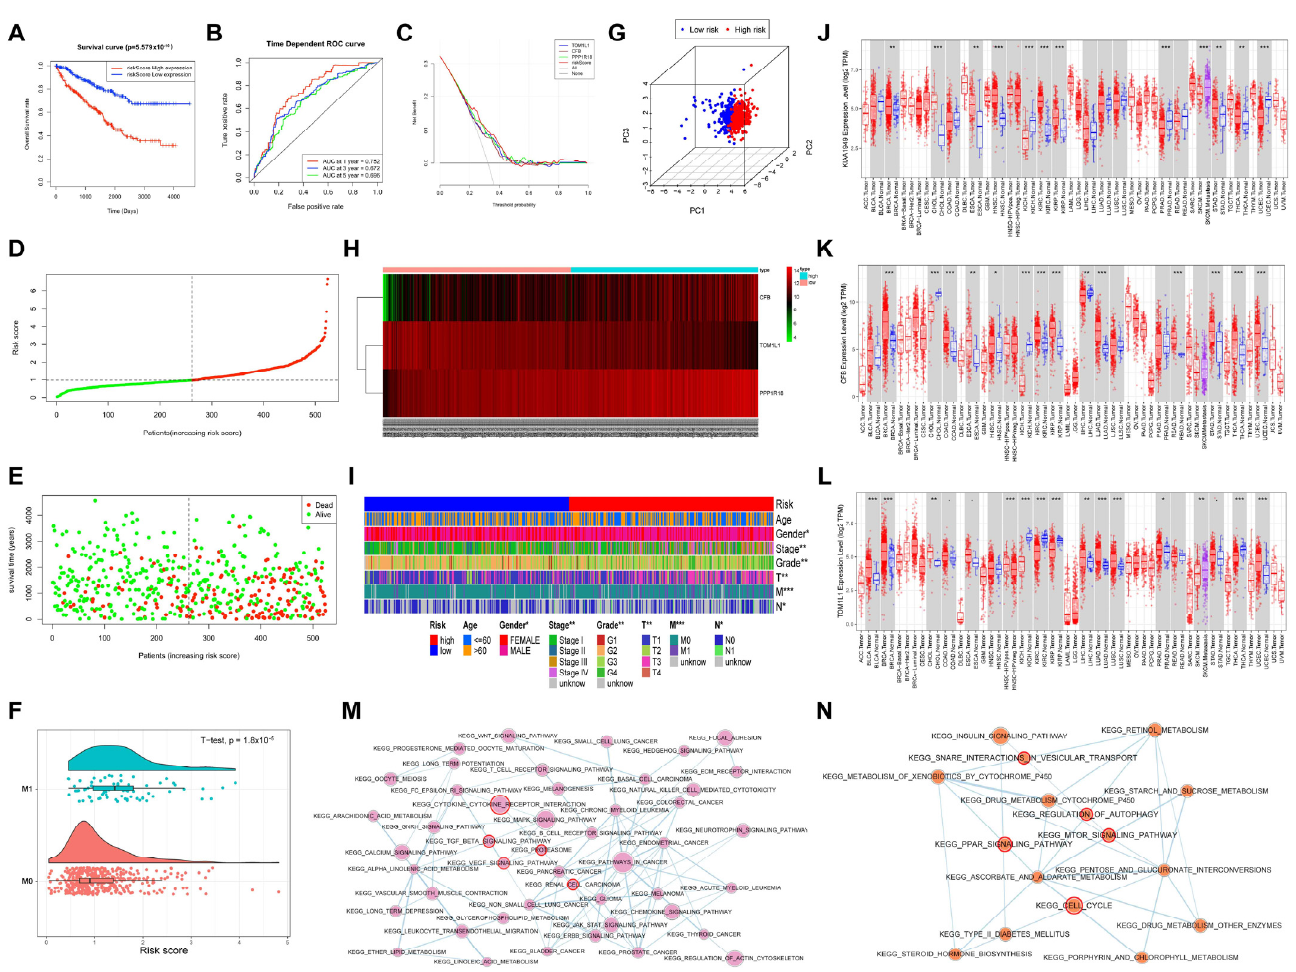
Figure 9. Evaluation and investigation of the prognostic panel. ( A ) OS analysis in the high- and low- risk groups. Time-dependent ROC curve ( B ) and DCA curve ( C ) of the risk score model. ( D ) Distri- bution of the risk scores of each patient with ccRCC in the TCGA set. ( E ) Survival status of patients with ccRCC with elevated risk scores. ( F ) Risk scores of patients with ccRCC were significantly cor- related with distant metastasis ( p < 0.001). ( G ) The independent expression distribution of the high- and low-risk groups was assessed using principal component analysis. ( H ) Heat map depicts the differential expression of the three key DMA-RMSGs between high- and low-risk patients. ( I ) The relationship between clinical traits and risk scores in TCGA. Pan-cancer analysis of KIAA1949/PPP1R18 ( J ), CFB ( K ), and TOM1L1 ( L ). The GSEA network revealed the pathways en- riched in low-risk patients ( M ) and high-risk patients ( N ). Representative gene sets are labeled with a red outline. p < 0.05 was considered statistically significant. ROC, receiver operating characteristic; DCA, decision curve analysis. * p < 0.05, ** p < 0.01, *** p < 0.001.